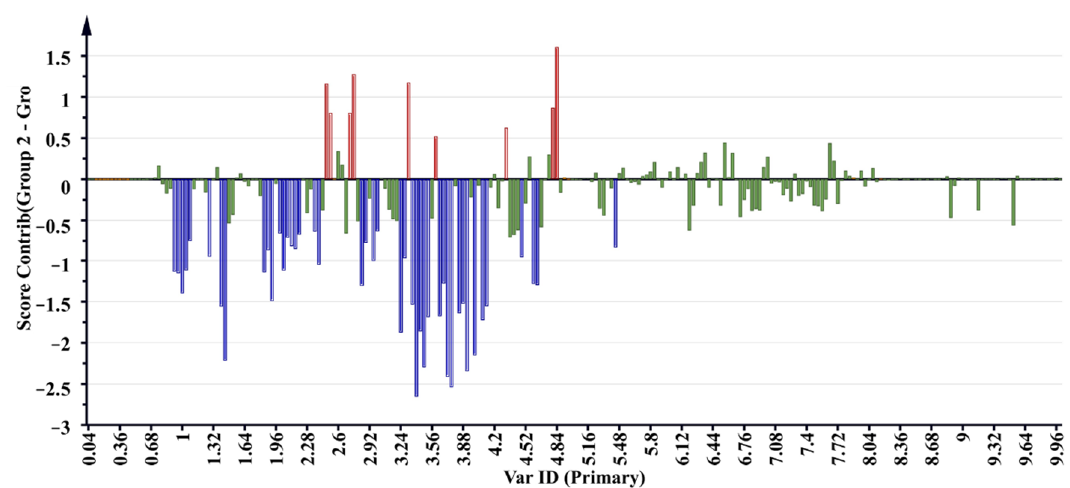
Figure 5. Contribution loading plot of samples representing regions responsible for the clustering of the samples, with bars above the line positively associated and bars below the line negatively associated with the activity.